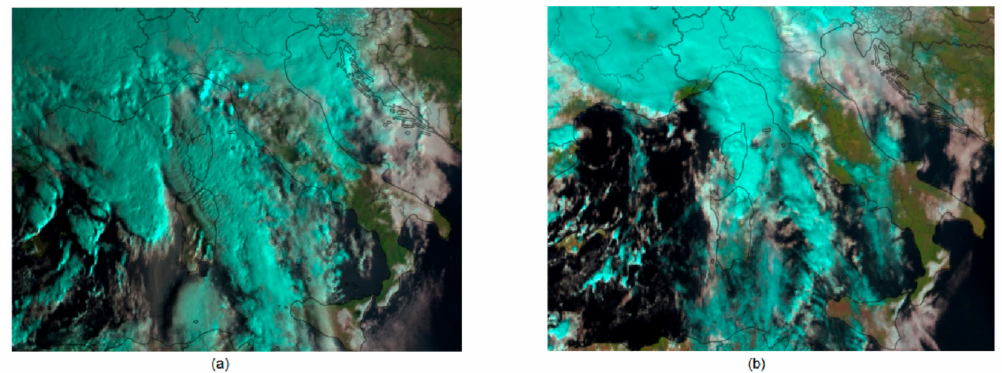
Figure 8. RGB composites—natural color from Meteosat satellite on 14 October 2016 at: ( a ) 9 UTC; ( b ) 12